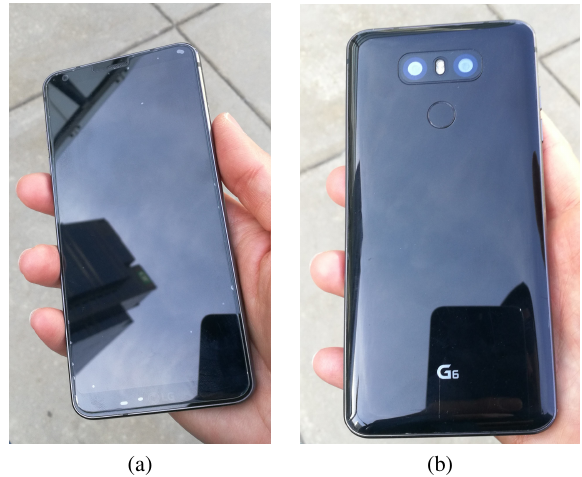
Figure 1. Smartphone LG G6: front (a) and rear view (b).